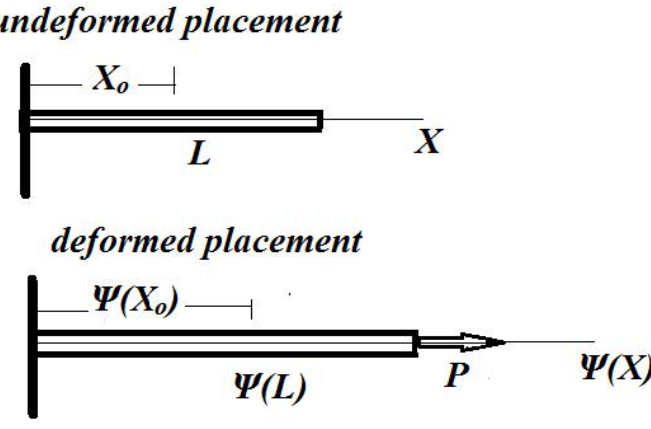
Figure 3. The bar in the fractional Λ -space.